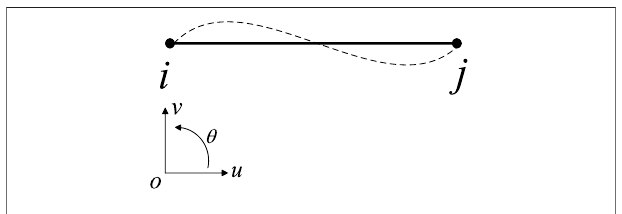
FIGURE 1 | Node displacement in local coordination.